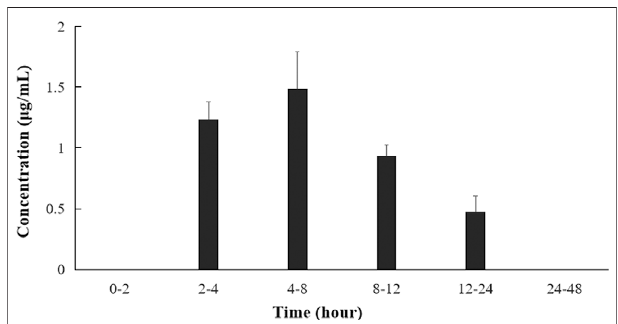
FIGURE 8 | Anwulignan concentrations in the feces of mice after the intragastric administration.